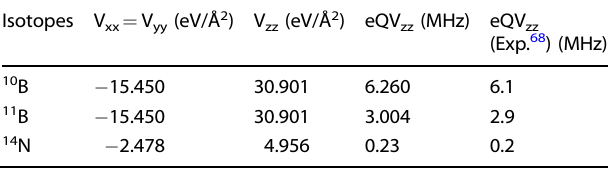
Fig. 1 Spin decoherence of V B − in bulk h-BN. a Schematic of the V B − spin in multi-layer h-BN. An external magnetic fi eld ( B 0 ) of 3 T is applied along the out-of-plane direction. Inset shows the ground-state spin density of V B − , computed using DFT. b Spin coherence of the V B − spin in multi-layer h-BN (black line). The spin coherence is fi tted with a stretched exponential function, exp (cid:2) t free = T 2 ð Þ n , to compute the spin coherence time (T 2 ) and stretching exponent ( n ). A hypothetical model of the bath in which the nuclear quadrupole interaction is ignored was considered for comparison (blue line). c Energy levels of two 10 B nuclear spins in the presence of Zeeman effect (H Z ) and a hyper fi ne fi eld (H Hyper ) imposed by the V B − electron spin (left) and in the presence of H Z , H Hyper , and the nuclear quadrupole interaction (H Q ) (right). d , e Detailed energy-level diagrams for the two speci fi c manifolds, denoted by the red and blue dotted lines in ( c ), ( d ) in the presence of H Z and H Hyper and ( e ) in the presence of H Z , H Hyper , and H Q . For a given manifold, transitions allowed by the dipolar fl ip- fl op interactions are denoted by red dotted arrows, and their transition rates are indicated as Ω FF . The energy splitting between the states in ( d ) is only induced by a small hyper fi ne fi eld (denoted as Δ HF ), whereas it is given by both the hyper fi ne and quadrupole interactions (denoted as Δ HF + Q ). Table 1. Electric fi eld gradients in h-BN, and the corresponding quadrupole coupling constants (eQV zz ) computed using